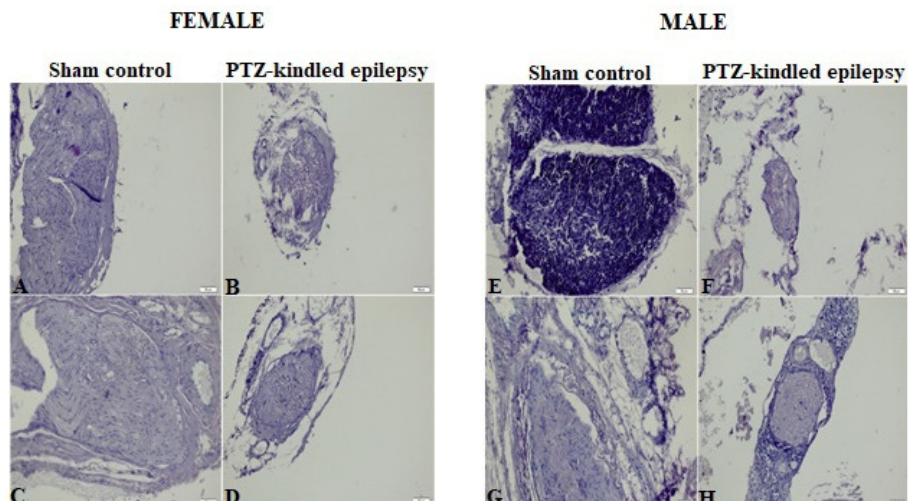
Figure 4. Representative HE staining images of VN sections stained with blue in sham control and PTZ-kindled epilepsy of rat model for male and female rats. For female; A : cervical VN image of control groups, B : thoracic VN image of control groups, C : Cervical VN image of PTZ-kindled epilepsy, D : Thoracic VN image of PTZ-kindled epilepsy. For male; E : cervical VN image of control groups, F : thoracic VN image of control groups, G : Cervical VN image of PTZ-kindled epilepsy, H : Thoracic VN image of PTZ-kindled epilepsy. Pictures were taken at a magnification of ×200. Scale bar: 50 μ m.